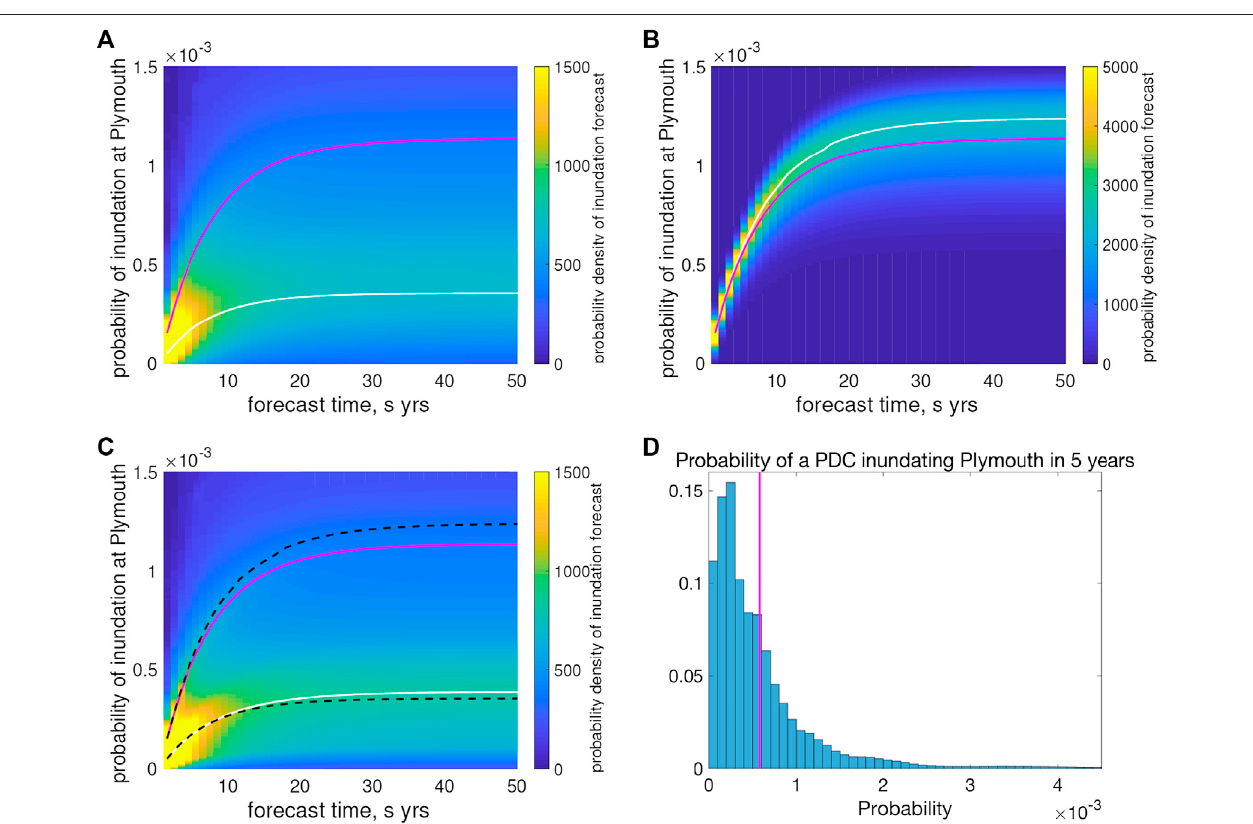
FIGURE10| Probabilitydensityfunctionestimates(incolor)offorecastinundationprobabilitiesatPlymouth(leftaxis)astheyevolveinforecasttime s (bottomaxis). In (A) uncertaintyintheseestimatesre fl ectsonlyuncertaintyintheposteriorprobabilitydistributionforthe fl owvolume V .In (B) uncertaintyintheseestimatesre fl ectsonly uncertainty in the posterior probability distribution for T , the eruption duration. In (C) uncertainty in these estimates re fl ects uncertainty in both the posterior probability distribution for the eruption duration T and the fl ow volume V . Evidently the dominant uncertainty is that in V . In all cases, the pink curve represents the mean of the probability density function estimates, and the white curves represent the mode of the mode of the posterior distribution of the inundation forecasts. In Panel (C) the modes from (A) and (B) are plotted as black dashed curves for reference (Note, color scales are truncated for visualization). Panel (D) shows histogram of posterior pdf for probability of inundation of Plymouth within next s (cid:2) 5 years, re fl ecting uncertainty in both volume V and end-of-eruption time T — a slice from panel (C) at abscissa s (cid:2) 5. Mean and 95% credible appear in bold on Table 1 .